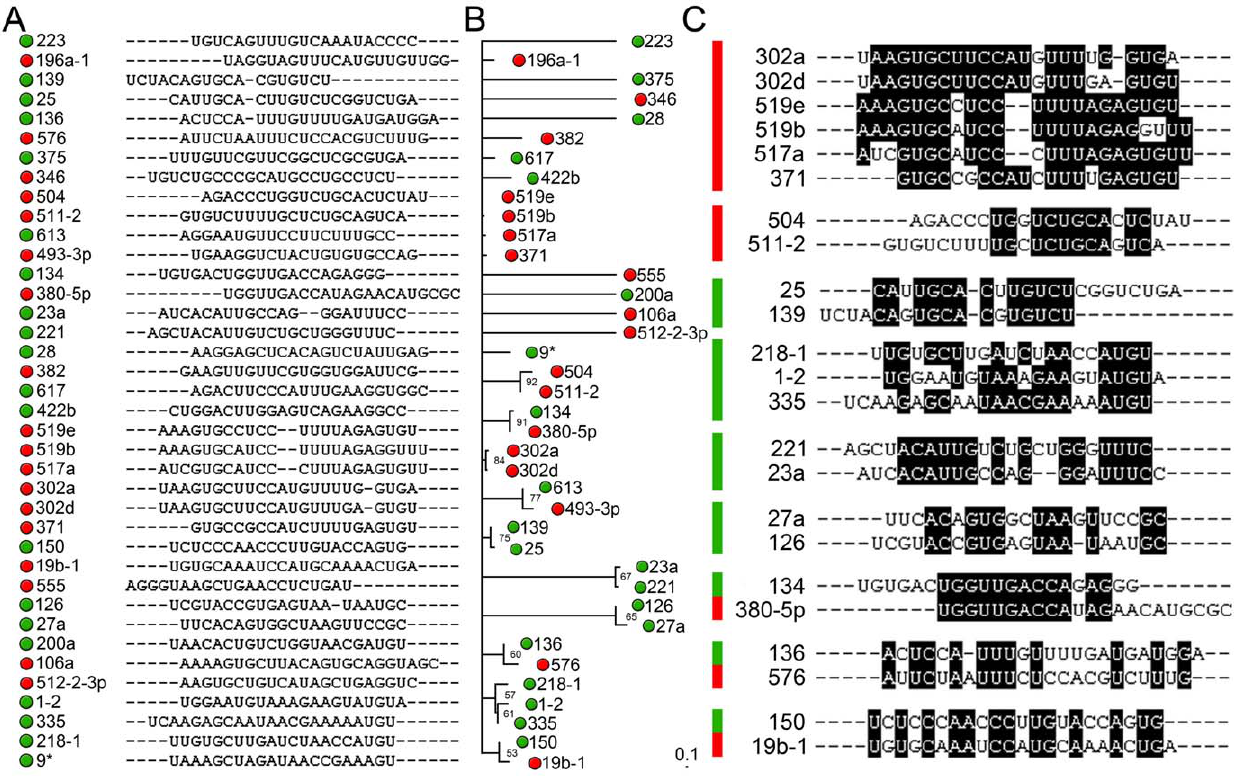
Figure 2. Alignment and tree of all validated Wnt-regulating Pre-miRs to represent and visualize sequence similarities. Numbers indicate Pre-miR designation. I. e. 233 stands for the mature hsa-Pre-miR-223 strand. Green: Pre-miR that was identified and verified as Wnt-inhibitory in the STF reporter assay. Red: Pre-miR that was identified as Wnt-activator/synergizer (A) Alignment of all mature strand selected verified Hsa-Pre- miRs (B) Quartet puzzling tree phylogram determined with tree-puzzle to visualize the degree of sequence similarities between all Pre-miRs based on nucleotide substitutions (C) Representative examples of miRs that share a high degree of sequence similarities. Note the enrichment of sequence similarity with unidirectional Wnt pathway modulation (see also Fig.